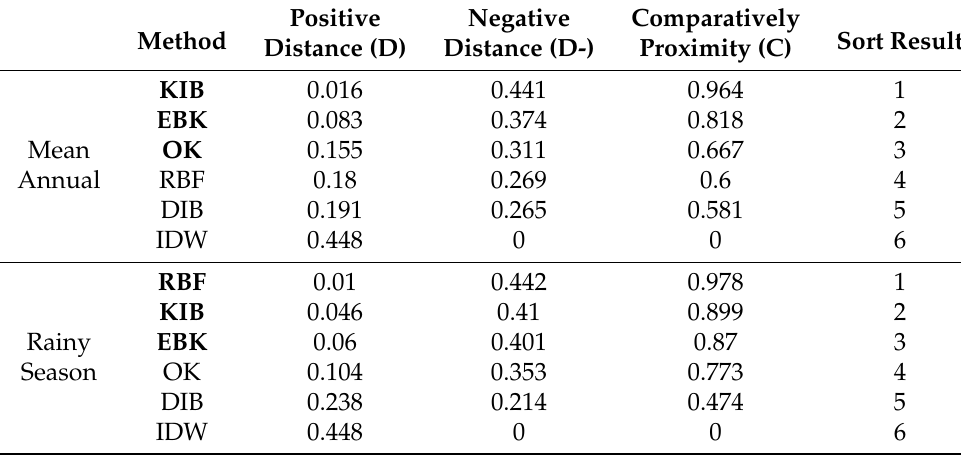
Table 2. TOPSIS superiority ranking of six spatial interpolation methods based on both different rainfall magnitudes and integrated multiple rainfall magnitudes. Methods with superior performance are shown in